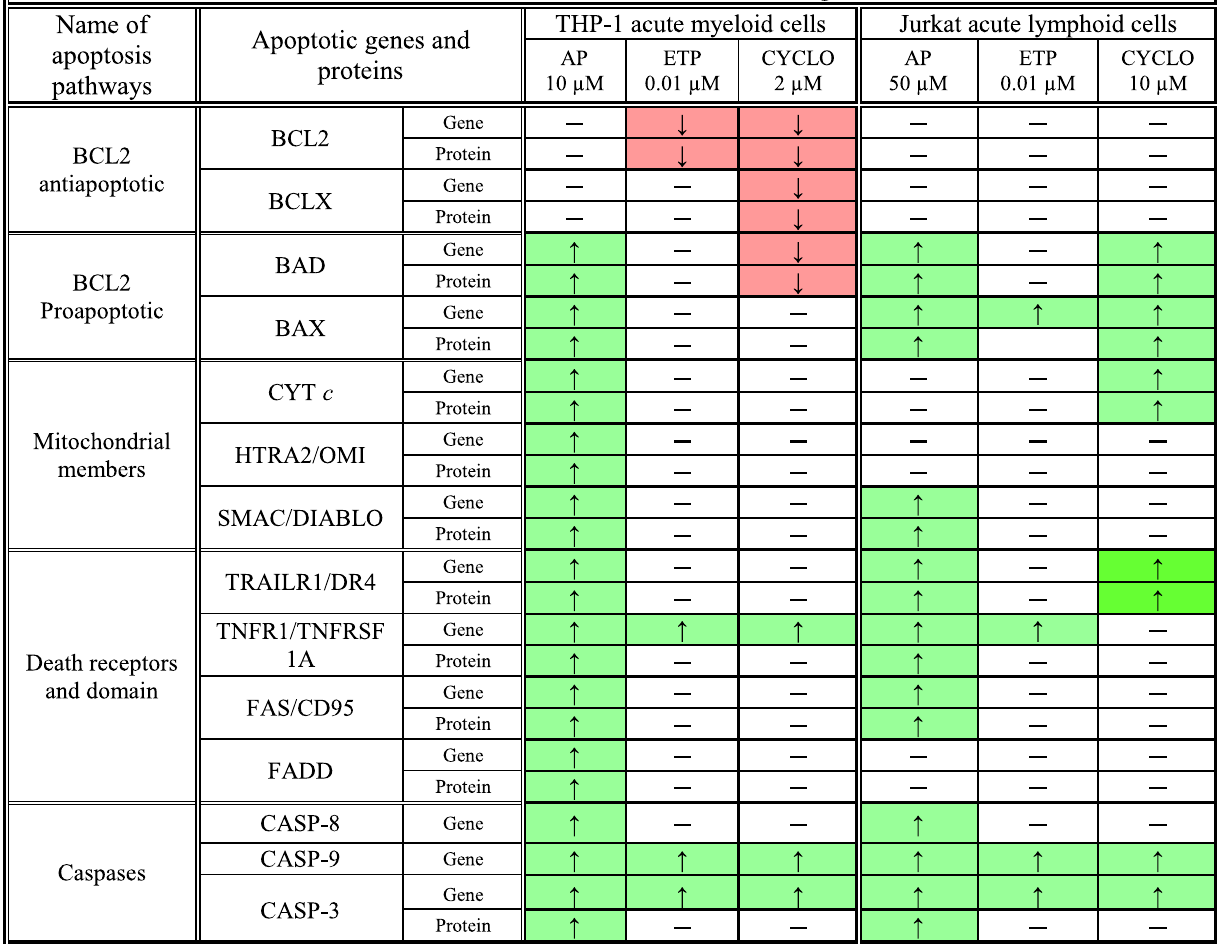
Table 1. A summary of the effects of individual treatments: apigenin (AP), etoposide (ETP), and cyclophosphamide (CYCLO) on the expression of apoptosis-related genes and proteins in acute myeloid (THP- 1) and lymphoid (Jurkat) leukaemia cell lines; using their lowest significant doses (LSDs) that induce apoptosis (previously determined in Mahbub et al., 2013, 2015, 2019) for 24 h treatment. A Kruskal Wallis with an Inman post-hoc test was used to determine statistical significance and P ≤ 0.05. The individual treatment effects were determined as described in Statistical